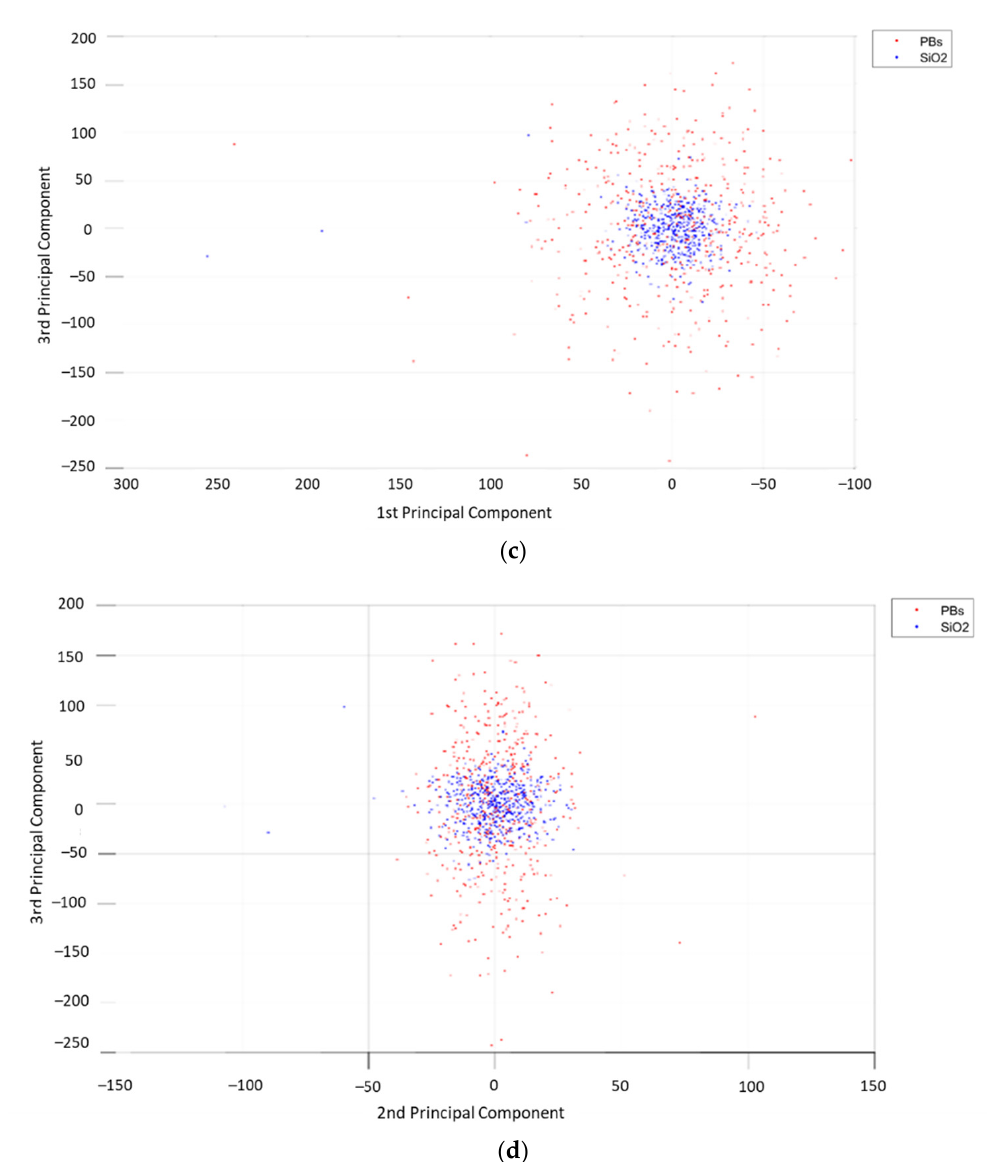
Figure 8. Principle component analysis of the different refractive indices of scatterers. ( a )—3-dimensional principal component scores of PBs and SiO 2 ; ( b )—the distribution of the groups along with 1st and 2nd components; ( c )—the distribution of the groups along with 1st and 3rd components; ( d )—the distribution of the groups along with 2nd and 3rd components. The 3-component solution included 95% of the variance within the data.